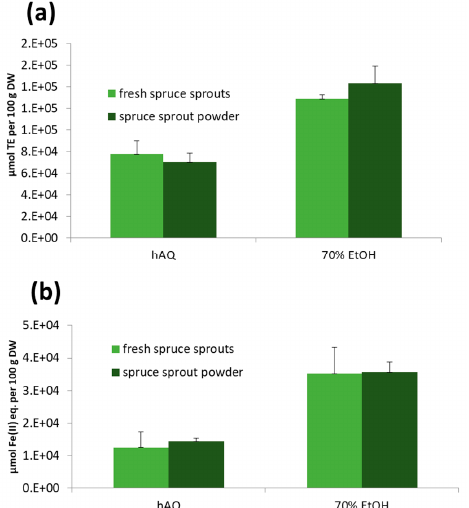
Figure 6. Oxygen radical absorbance capacity (ORAC) ( a ) and ferric ion reducing antioxidant power (FRAP) ( b ) of fresh sprouts and freeze-dried sprout powder of Norway spruce after water (hAQ) and 70% ethanol (70% EtOH) extractions in 2017–2019. The results are calculated per 100 g dry weight (DW). The error bars indicate standard deviations.